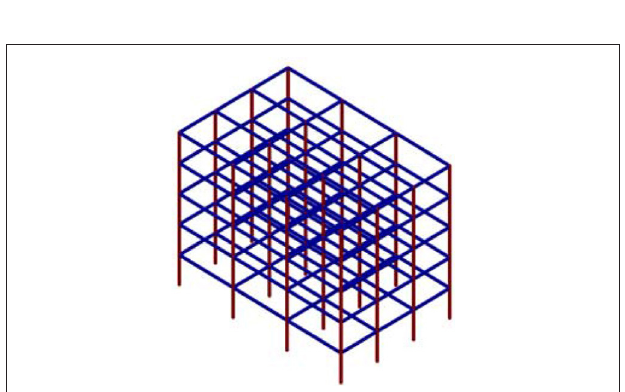
FIGURE 5 | Analytical model of 3D structure used in the optimization process.